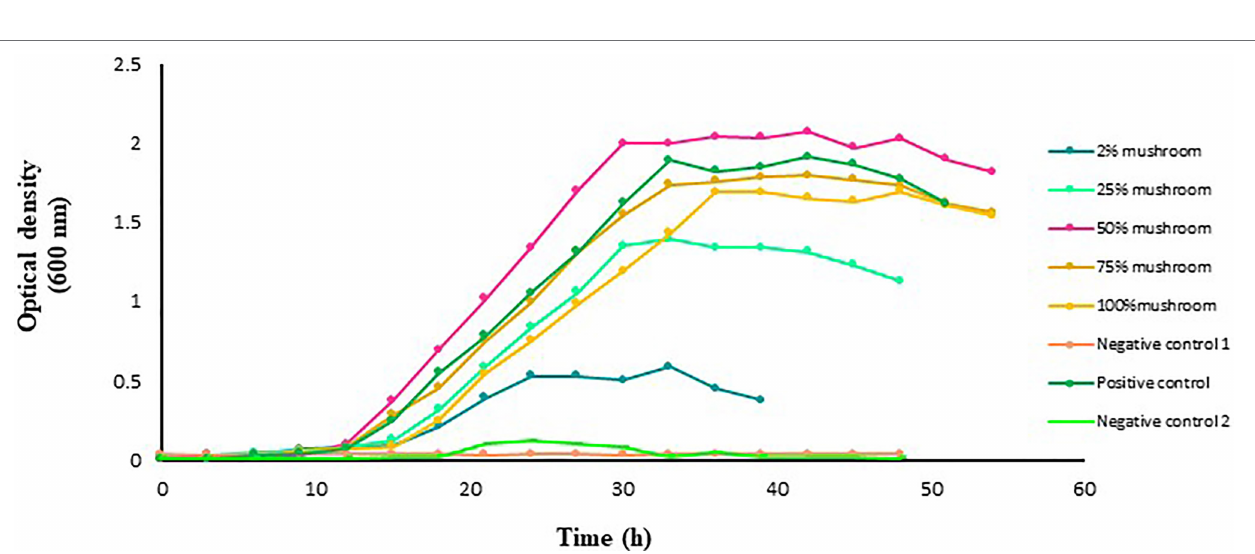
FIGURE 2 | Growth of L. acidophilus in MRS broth medium with and without mushroom extract added at an increasing concentration of 2, 25, 50, 75, or 100%. Lactobacillus acidophilus grown in MRS broth medium with a standard amount of glucose served as a positive control. The glucose-free MRS medium with 100% of mushroom extract and without L. acidophilus served as negative control 1. The MRS medium free from both glucose and extract but with L. acidophilus served as negative control 2. The data points are the mean values of three